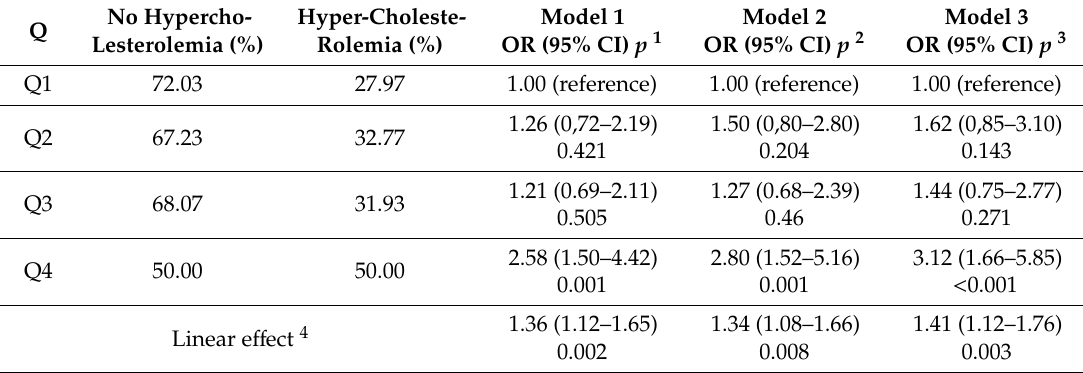
Association between quartiles (Q) of plasma magnesium levels and the risk of